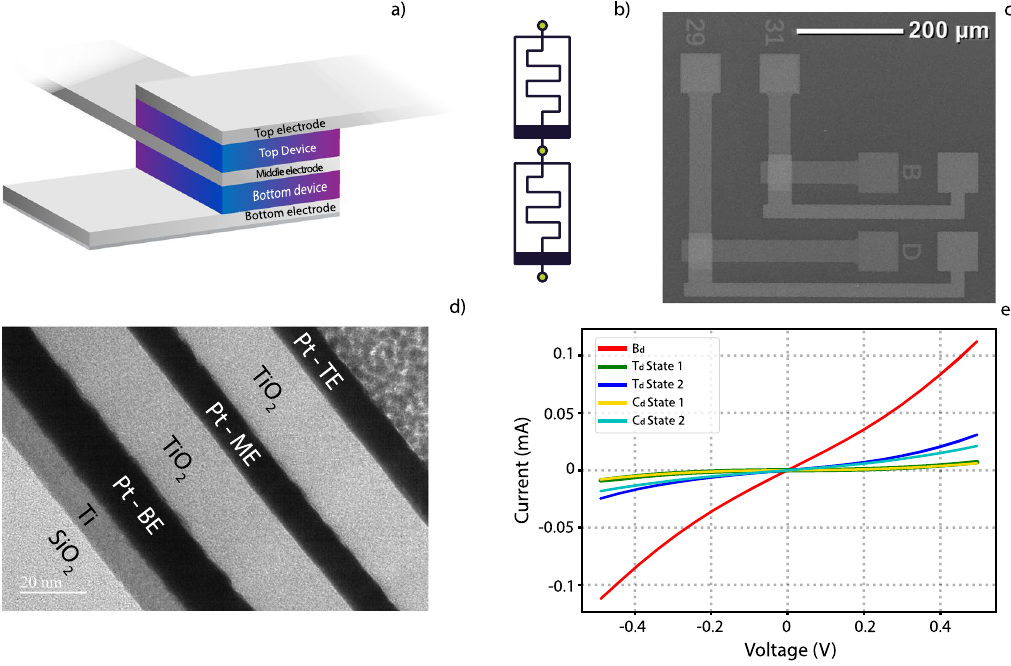
Figure 1. Physical and electrical characteristics of MIMIM devices. ( a ) Graphical depiction of device topology, while ( b ) electrical equivalent model (’serial’ connection). ( c ) SEM image of the fabricated devices, illustrating the 3 electrodes and their overlap areas which constitute the devices. ( d ) TEM image of the overlap area, showing the vertical stacking of the fabricated devices. ( e ) non-switching IVs of a stack, whereby the IV of the Complete device is dependent on the IVs of the top (T d ) and Bottom devices (B d ), and the resulting voltage division between the two. In this case, two distinct states for the Top device (T d State 1 and T d State 2) were registered and the switching impact on the Complete device (Cd) has been recorded, as depicted in C d State 1 and C d State